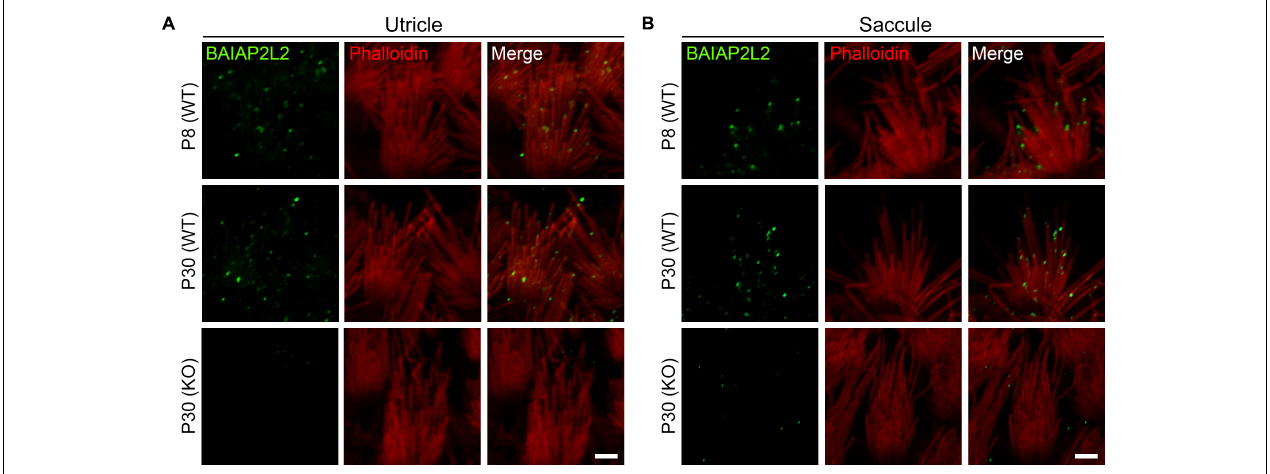
FIGURE 1 | BAIAP2L2 is localized at the tips of shorter-row stereocilia in VHCs. Whole-mount immunostaining using a specific anti-BAIAP2L2 antibody (green) was performed to examine the localization of BAIAP2L2 in the stereocilia of utricular (A) and saccular (B) hair cells. Steoreociliary F-actin core was visualized using TRITC-conjugated phalloidin (red). The genotypes and ages of mice are indicated. Scale bar, 2 µ m.